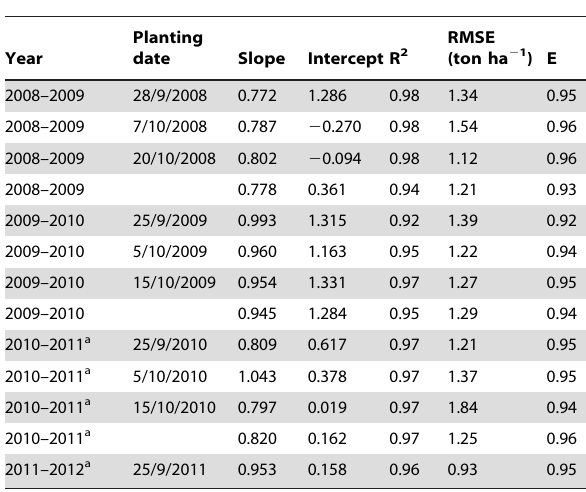
Table 6. Simulated and measured biomass yield (BY) for winter wheat under different planting dates in 2008/2009,